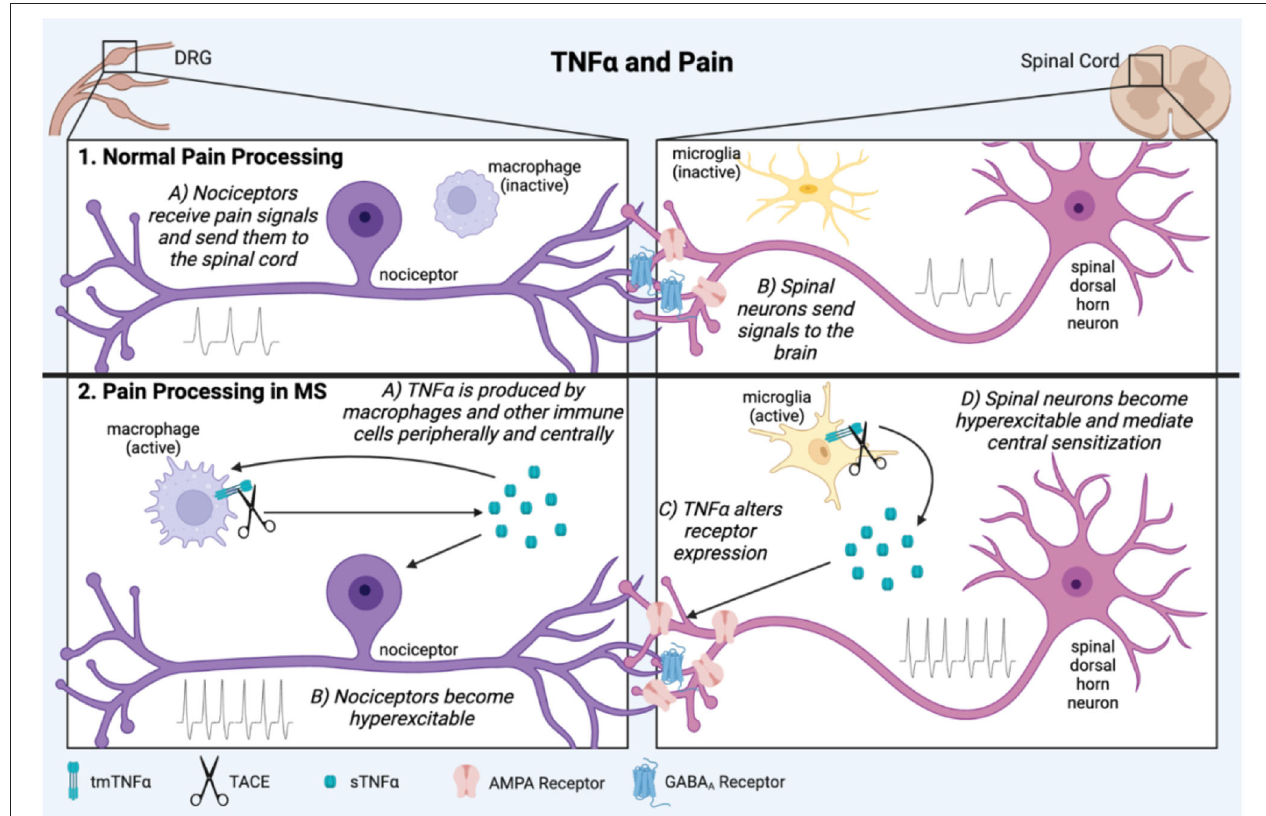
FIGURE 2 | TNF α is involved in pathological pain processing in MS. In normal physiological pain processing, pain signals are sent from the periphery to the DRG, which relays information to the spinal cord then brain (1A,B). In neuropathic pain in MS, inflammation activates immune cells which secrete the pro-inflammatory cytokine, TNF α both peripherally and centrally (2A). It can then act back on the cells which produced it creating a positive feedback loop. TNF α contributes to sensitization of peripheral nociceptors and spinal dorsal horn neurons through mechanisms such as altered excitatory and inhibitory receptor expression (2B,C). These conditions lead to long term central pain sensitization of the brain and spinal cord (2D). This figure was made using